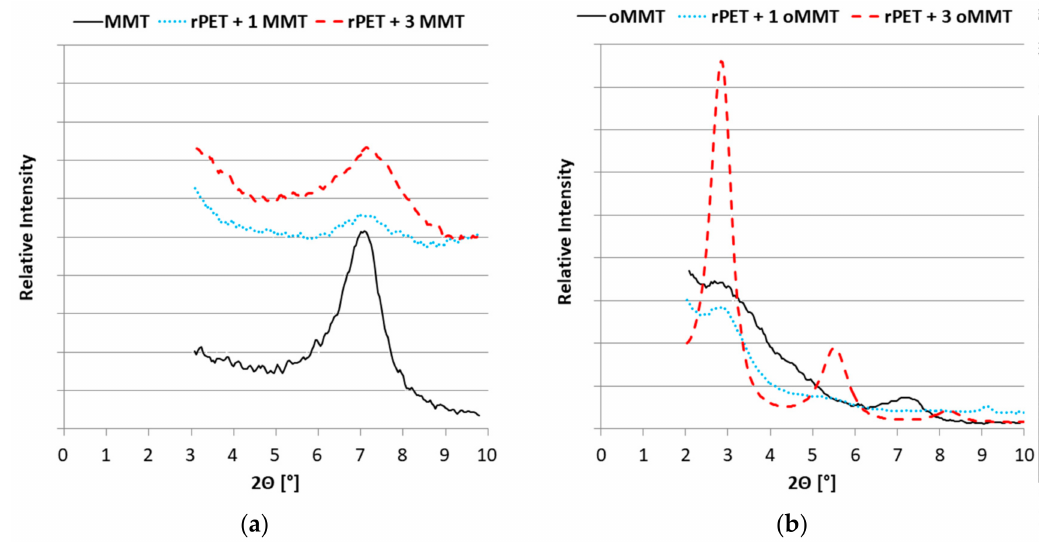
Figure 1. Interlayer spacing of MMT ( a ) and oMMT ( b ).